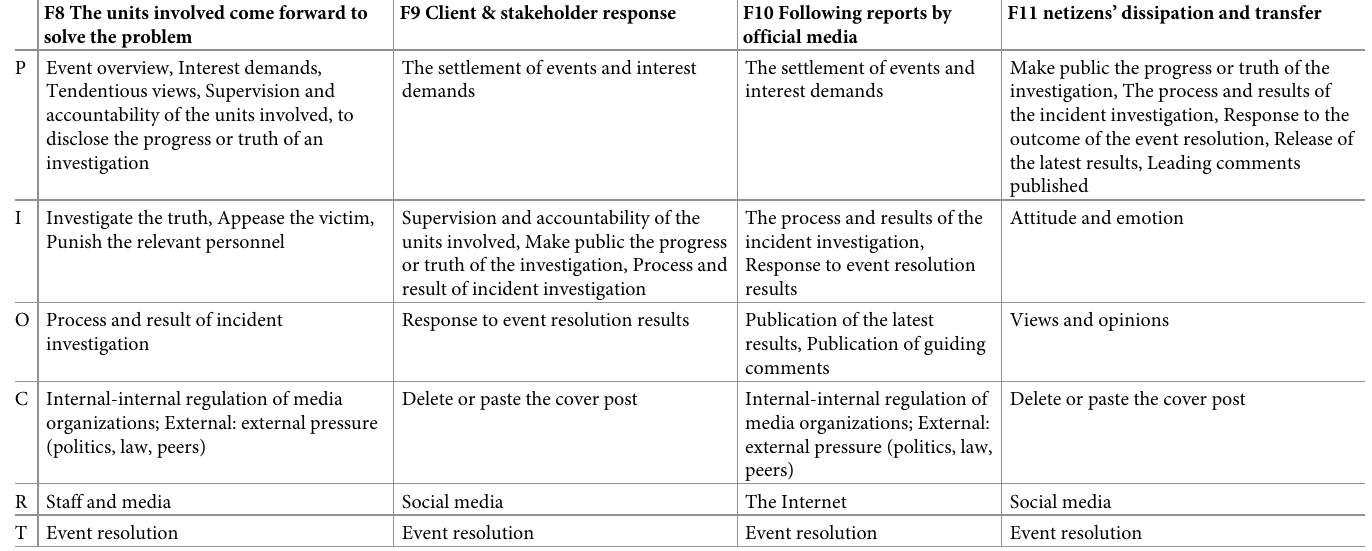
Table 3. The functions in the dissipation.